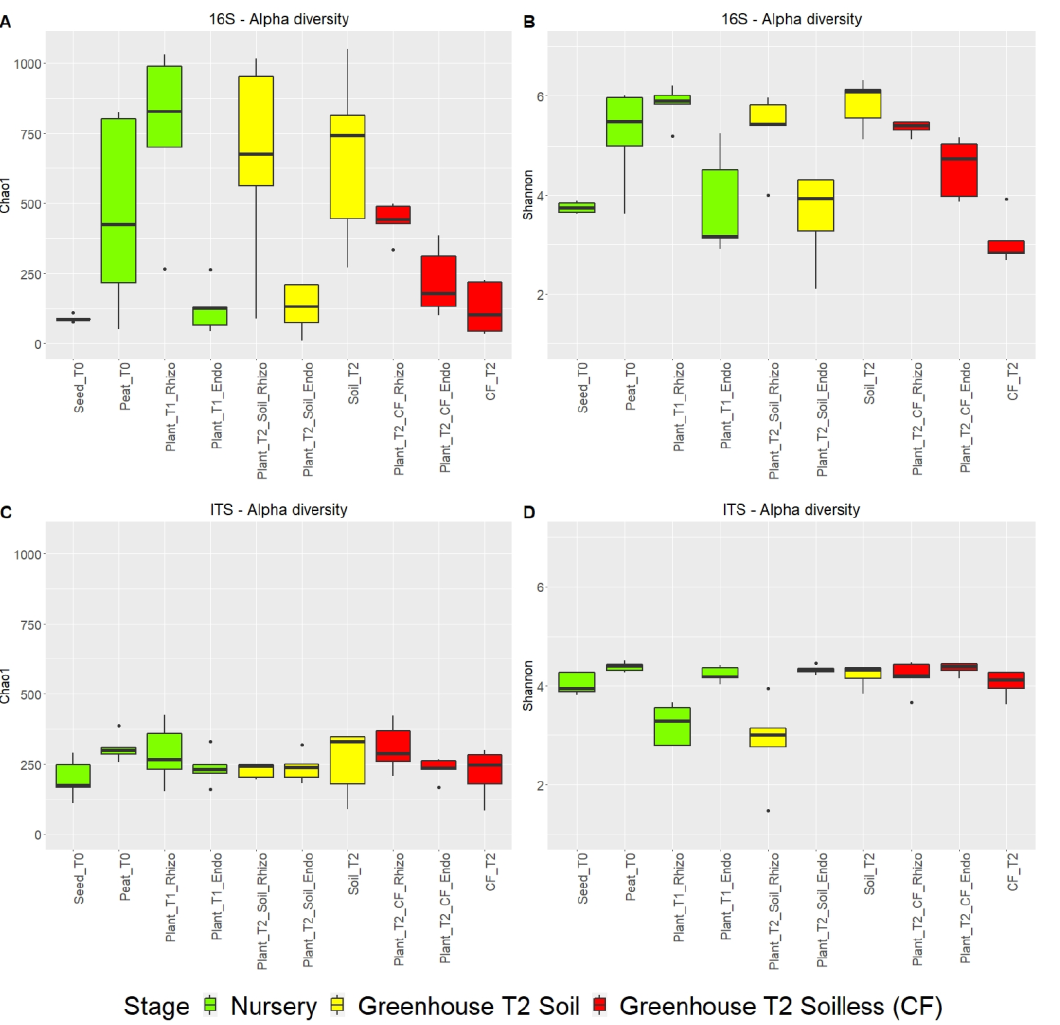
Figure 4. Estimation of the alpha diversity of the microbiome bacterial community ( A , B ); and fungal community ( C , D ) in the different samples of the tomato crop chain based on amplicon sequencing data. The observed Chao1 and Shannon indices were used in the alpha diversity